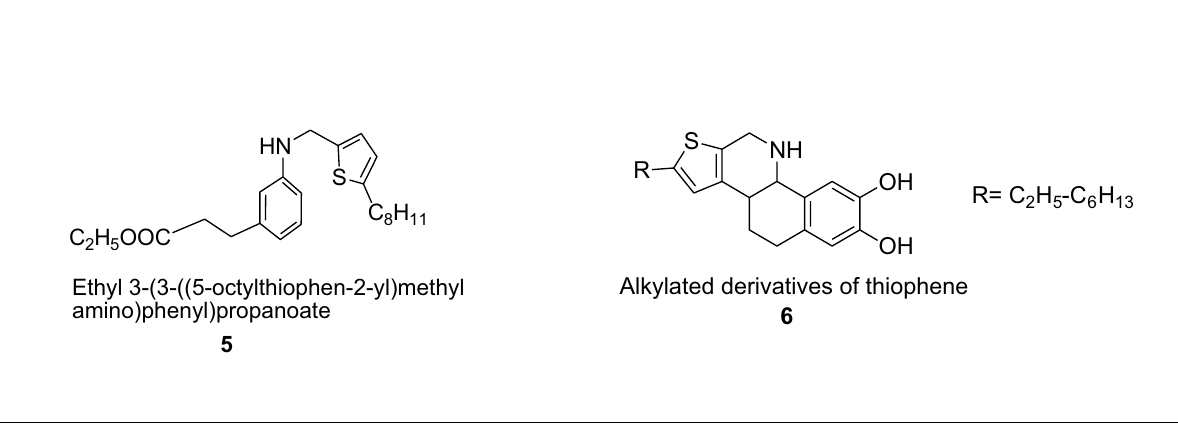
Antimicrobial activity Thiophene derivatives show high antimicrobial activ-